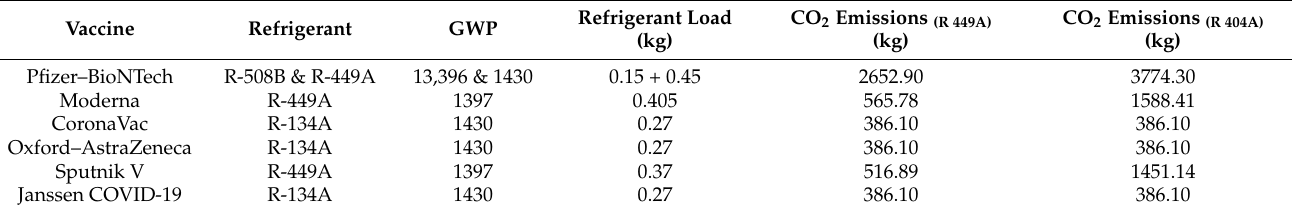
Table 4. Vaccines and